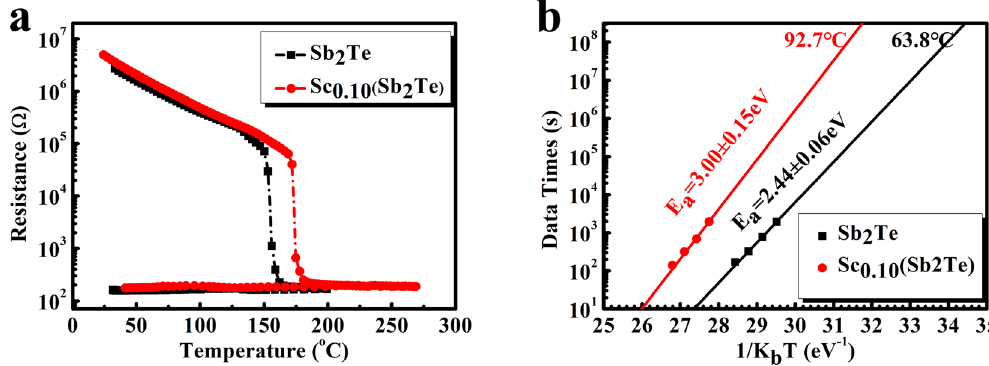
Figure 1. ( a ) R-T curves for Sb 2 Te and Sc 0.1 Sb 2 Te films with a heating rate of 20 °C/min. ( b ) The Arrhenius extrapolation plots of 10-year data retention time versus 1/K b T for Sb 2 Te and Sc 0.1 Sb 2 Te